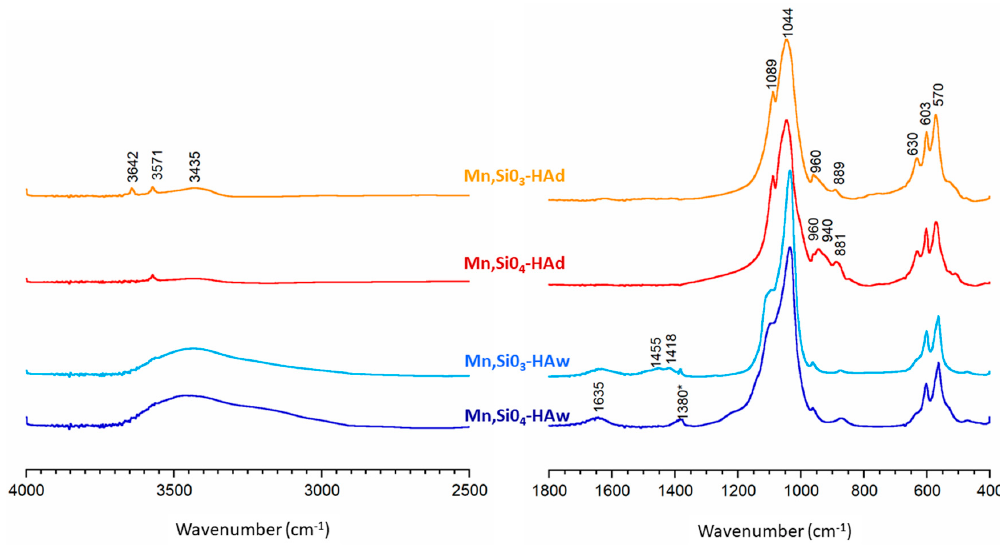
Figure 3. FTIR transmission spectra of the analyzed samples.